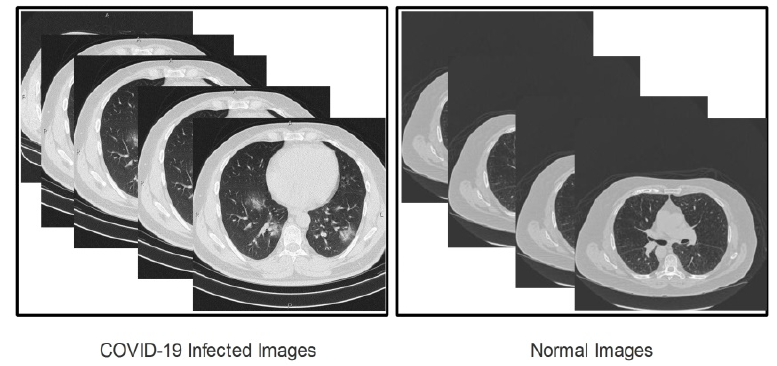
Figure 2. Sample of COVID-19-positive and normal (healthy) images.